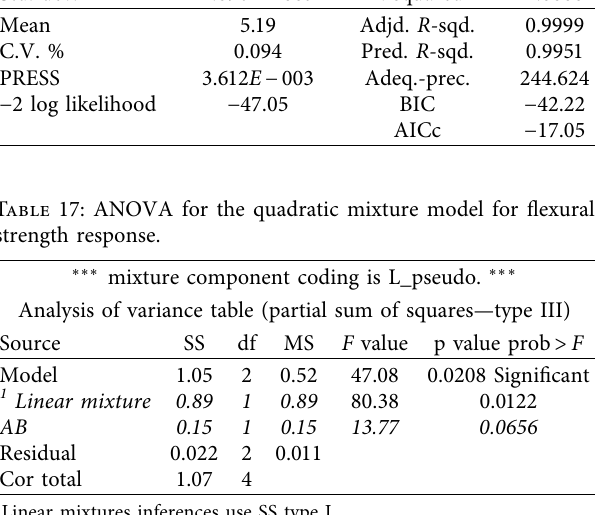
Table 16: R-sqd. calculations for compressive strength response. Std. dev.